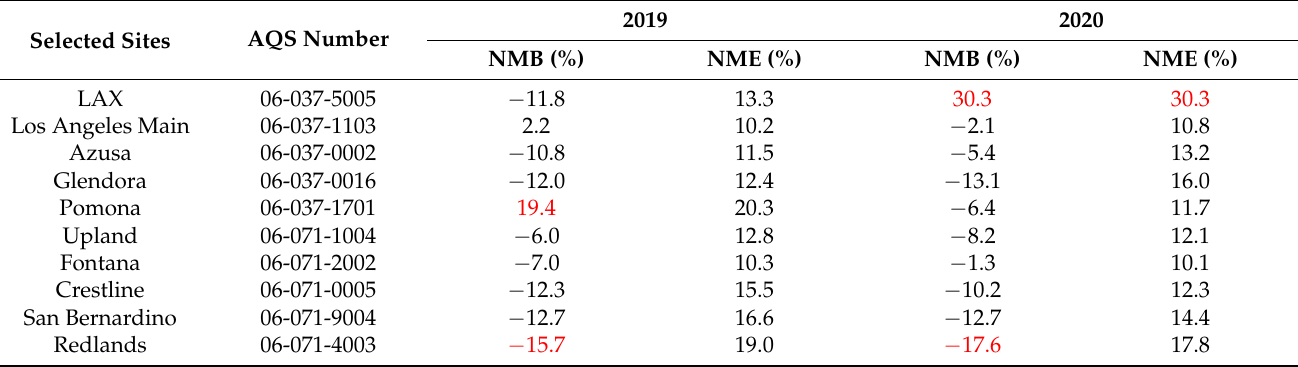
Table 2. NMB and NME for the T10 modeled days used in the RRF calculations 1 .